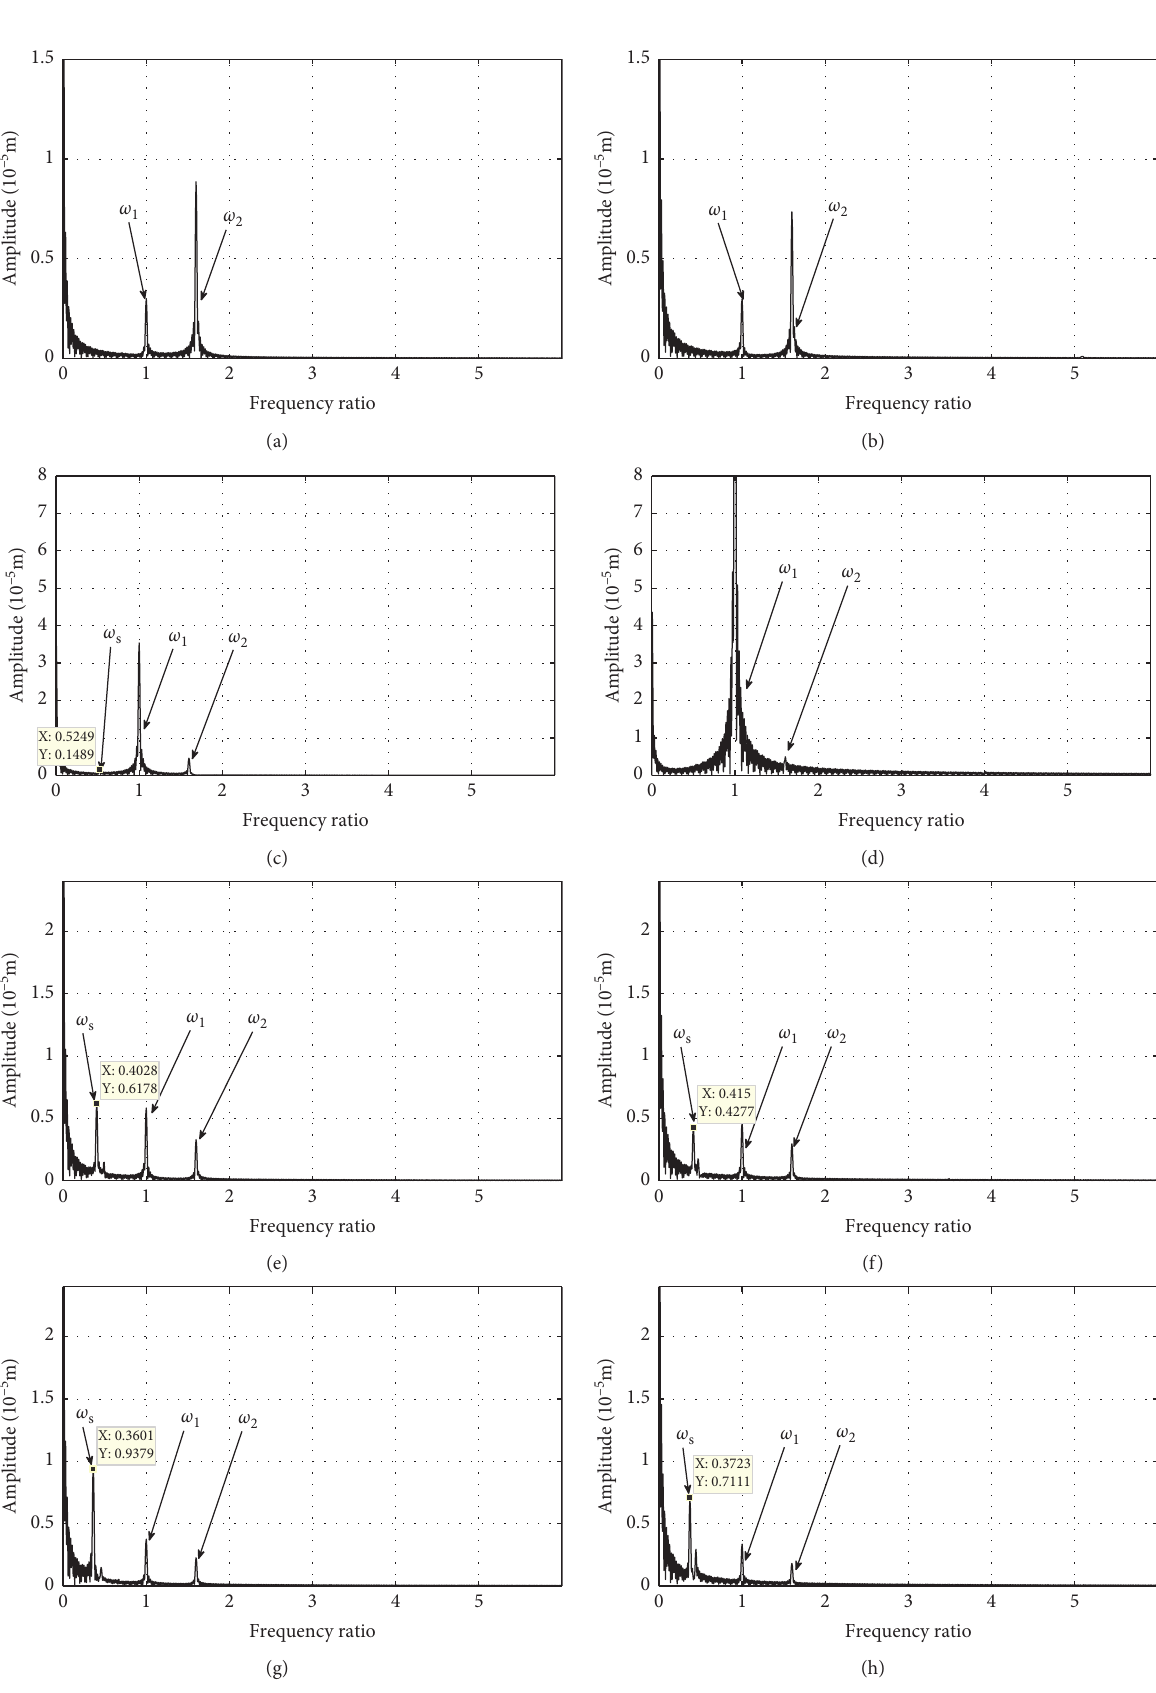
Figure 22: Spectrograms for the vertical vibration of disk 4. (a) 300rad/s, λ � 1 . 6. (b) 300rad/s, λ � − 1 . 6. (c) 400rad/s, λ � 1 . 6. (d) 400rad/s, λ � − 1 . 6. (e) 500rad/s, λ � 1 . 6. (f) 500rad/s, λ � − 1 . 6. (g) 550rad/s, λ � 1 . 6. (h) 550rad/s, λ � − 1 .